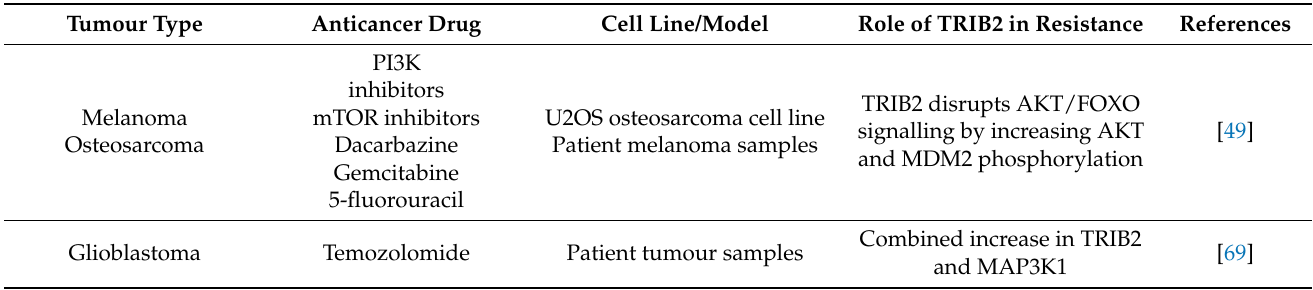
Table 3. Role of TRIB2 in chemotherapy